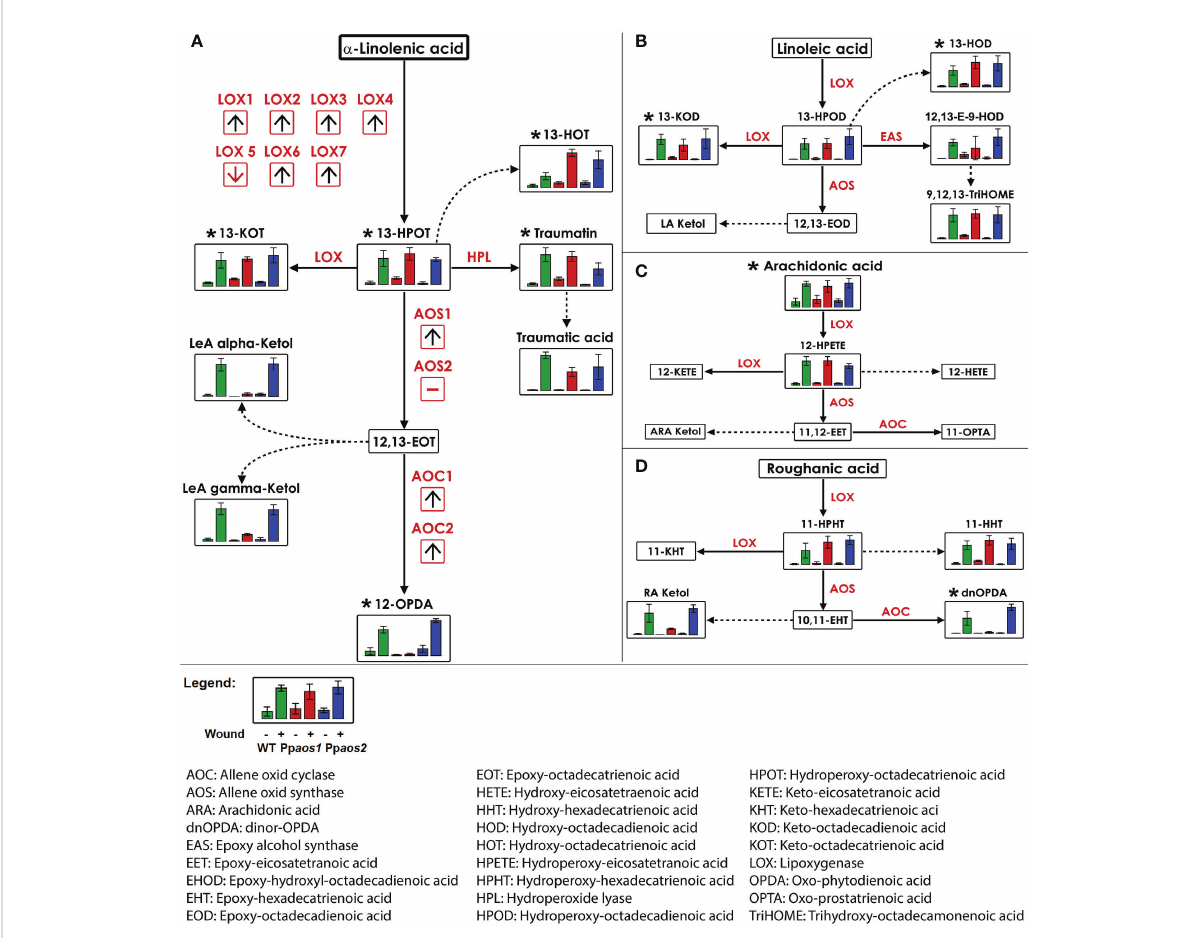
FIGURE 2 Reconstruction of LOX-pathways from metabolite fi ngerprinting data of a P. patens wounding experiment (WT, Ppaos1 , and Ppaos2 ). Data of a non-targeted metabolome analysis acquired by UPLC-HR-MS were used for the reconstruction of LOX pathways derived from: (A) a -linolenic acid, (B) linoleic acid, (C) arachidonic acid, (D) roughanic acid. Bars show relative intensities (mean values with standard deviations) of the indicated compound of P. patens wild type (green), Ppaos1 (red) and Ppaos2 (blue) lines for control (left) and wounded gametophores (30 min past wounding, right) each. Dotted lines represent spontaneous reactions without enzymatic catalysis. Metabolites were annotated by accurate mass information. Metabolites marked with (*) were unequivocally con fi rmed by coelution with authentic standards and/or MS/MS experiments (Supplementary Table 2). Transcriptome data of a wounding experiment with P. patens (Hiss et al., 2014) were visualized in red boxes. Red arrows indicate the regulation of the transcript two hours post wounding by detaching lea fl ets from wild type moss. Pathway visualization was applied using VANTED 2.1.0 software (Rohn et al., 2012). Data represent three moss cultures per treatment. Comparable data were obtained from two independent